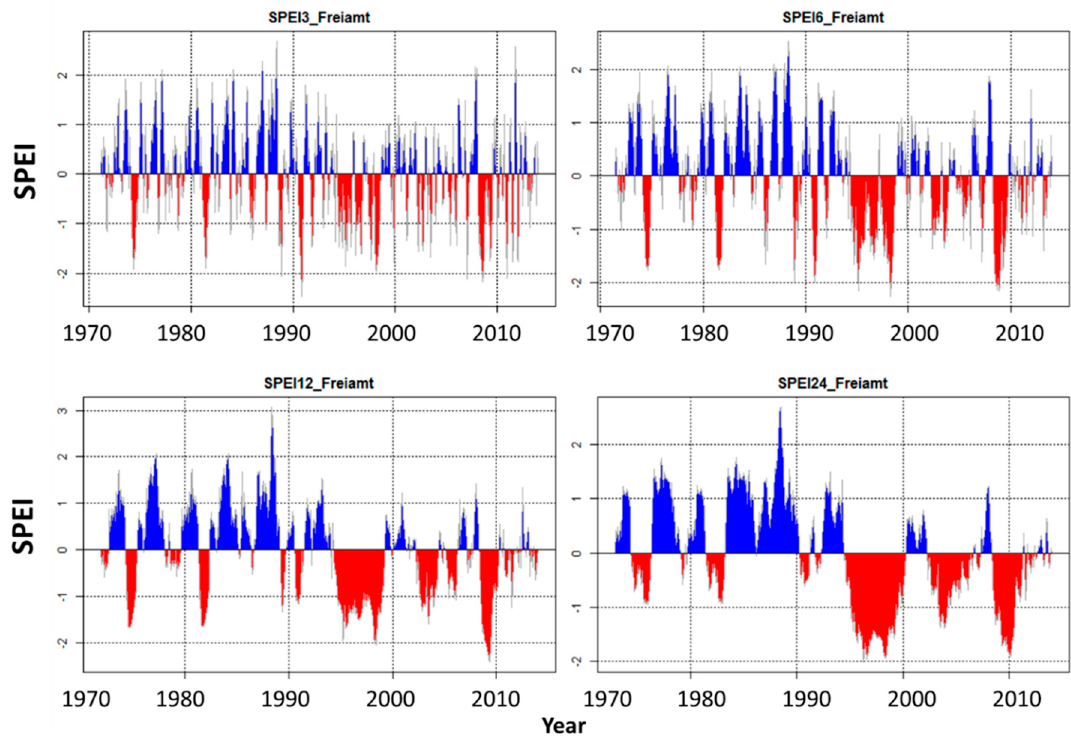
Figure 2. Monthly standardized precipitation evapotranspiration index (SPEI) using the climate data from a meteorological station near Freiamt (Black Forest, Germany) (1973–2017). Positive values indicate that the difference between monthly precipitation and potential evapotranspiration is larger than the average for a given monthly period. Negative values thus represent conditions drier than average. The monthly periods used were 3, 6, 12 and 24 months for SPEI-3, SPEI-6, SPEI-12 and SPEI-24, respectively.